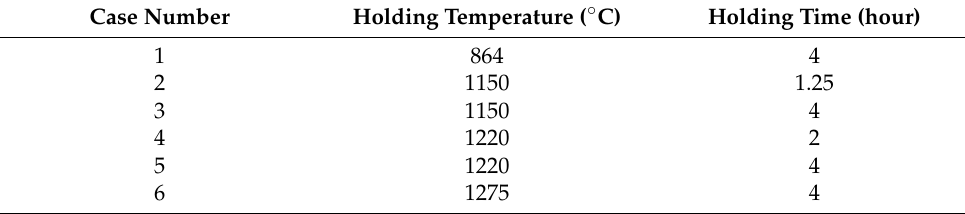
Table 1. List of vacuum heat-treatment